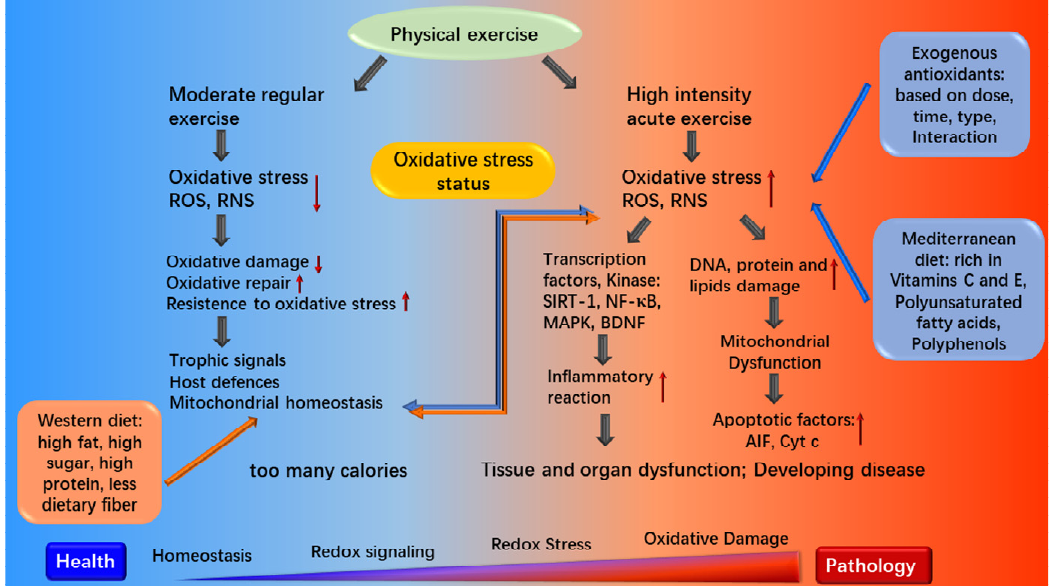
Figure 3. Associations between dietary patterns and physical exercise. SIRT-1, sirtuin1; MAPK, mitogen-activated protein kinase; BDNF, brain-derived neurotrophic factor; AIF, apoptosis inducing factor; Cyt c, Cytochrome C.